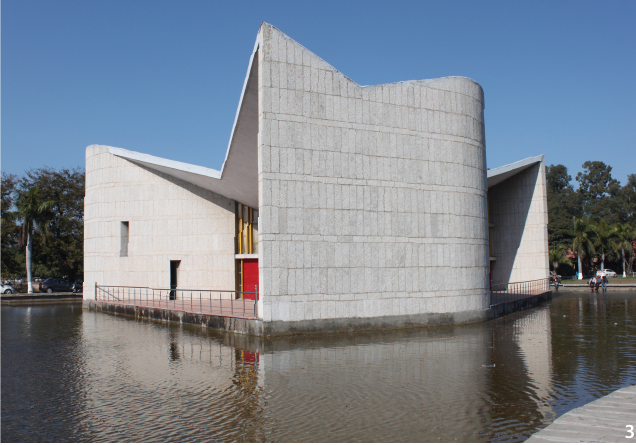
Figure 3 The Gandhi Bhawan in Chandigarh, India (Source: Vanicka